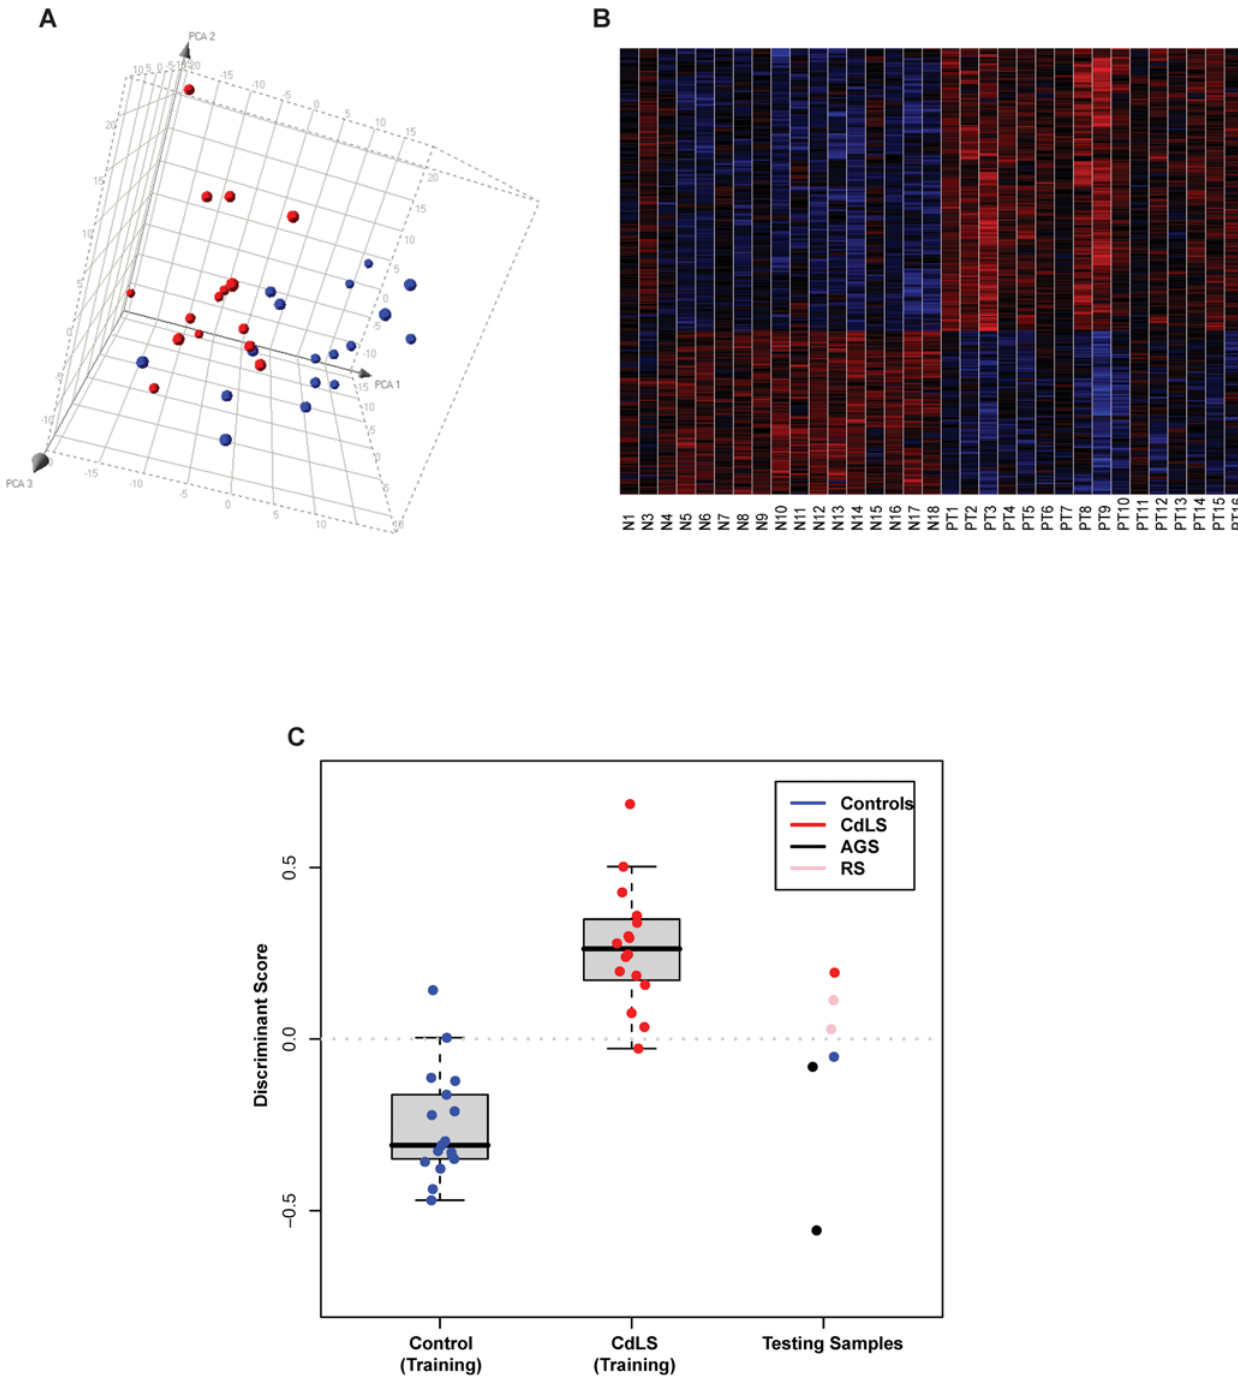
Figure 1. Classifications of the 33 training samples by gene expression. (A) Unsupervised clustering of 17 healthy controls (blue dots) and 16 severe CdLS probands (red dots) by principle component analysis (PCA) of the 27,995 probe sets actively transcribed in LCLs. The separation between the training groups indicates that controls and probands have different gene expression patterns. (B) Heatmap showing that the identified 420 probe sets (FDR , 0.01) are expressed dramatically differently between CdLS probands (PT) and healthy controls (N). Red represents genes that are upregulated and blue represents genes that are downregulated. The left 17 columns represent control samples, and the right 16 columns represent proband samples. Rows display gene expression levels. (C) Nearest centroid classifications of the 33 training samples and six testing samples. Among the training samples, two healthy controls and one CdLS proband were misclassified after Leave-One-Out cross validation. Among the testing samples, CdLS probands and two RBS probands were classified into CdLS group whereas the one healthy control and two probands with AGS were classified into the control group.